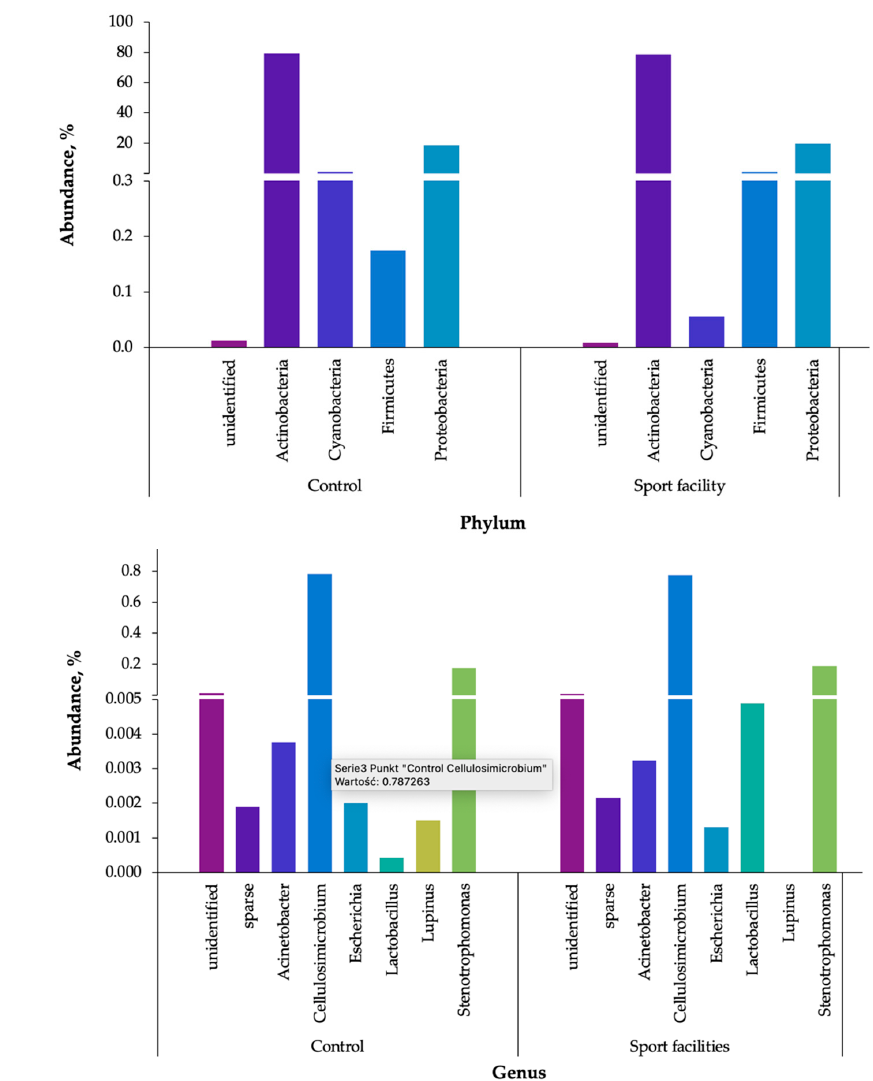
Figure 6. Phylogenetic distribution of bacteria sequences in the bioaerosols samples; ( a ) assigned to the phyla, ( b ) assigned to the genera; unidentified—unidentified sequences; sparse—reads assigned to low abundant phyla (less than 0.1% of all classified reads).